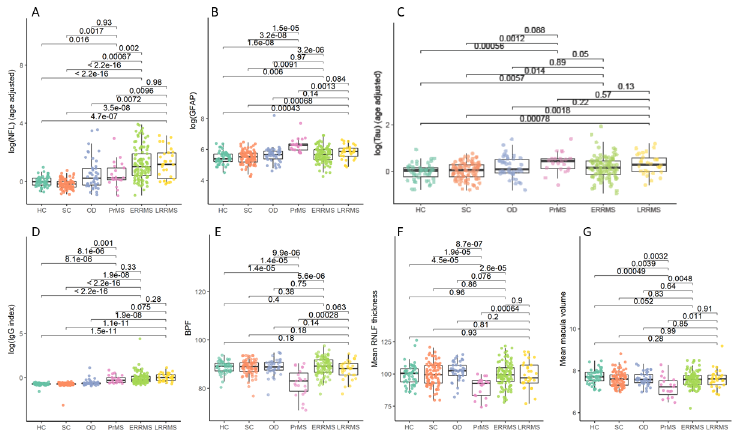
Fig 1. Comparison of biomarker levels among groups with and without multiple sclerosis. (A) NFL (age adjusted) levels, (B) GFAP levels, (C) tau levels, (D) IgG index, (E) BPF values, (F) RNFL thickness, and (G) macula volume in control groups (HC, SC) and in patients with OD, PrMS, CIS/early RRMS (with disease duration < 2 years; ERRMS), and established RRMS (disease duration (cid:21) 2 years; LRRMS). Dots represent the log of the biomarker values or the tissue properties measured in each subject. Boxes are the IQRs and horizontal lines are the median values. Brackets indicate pairwise group comparisons with corresponding p-values. The age adjusted log(NFL) was calculated, as follows: log(NFL)– 4.24–0.040 (cid:3) Age (y), as estimated by linear regression of the HC group. The age adjusted log(tau) was calculated, as follows: log(tau)– 5.75 + 0.015 (cid:3) Age (y), as estimated by linear regression of the HC